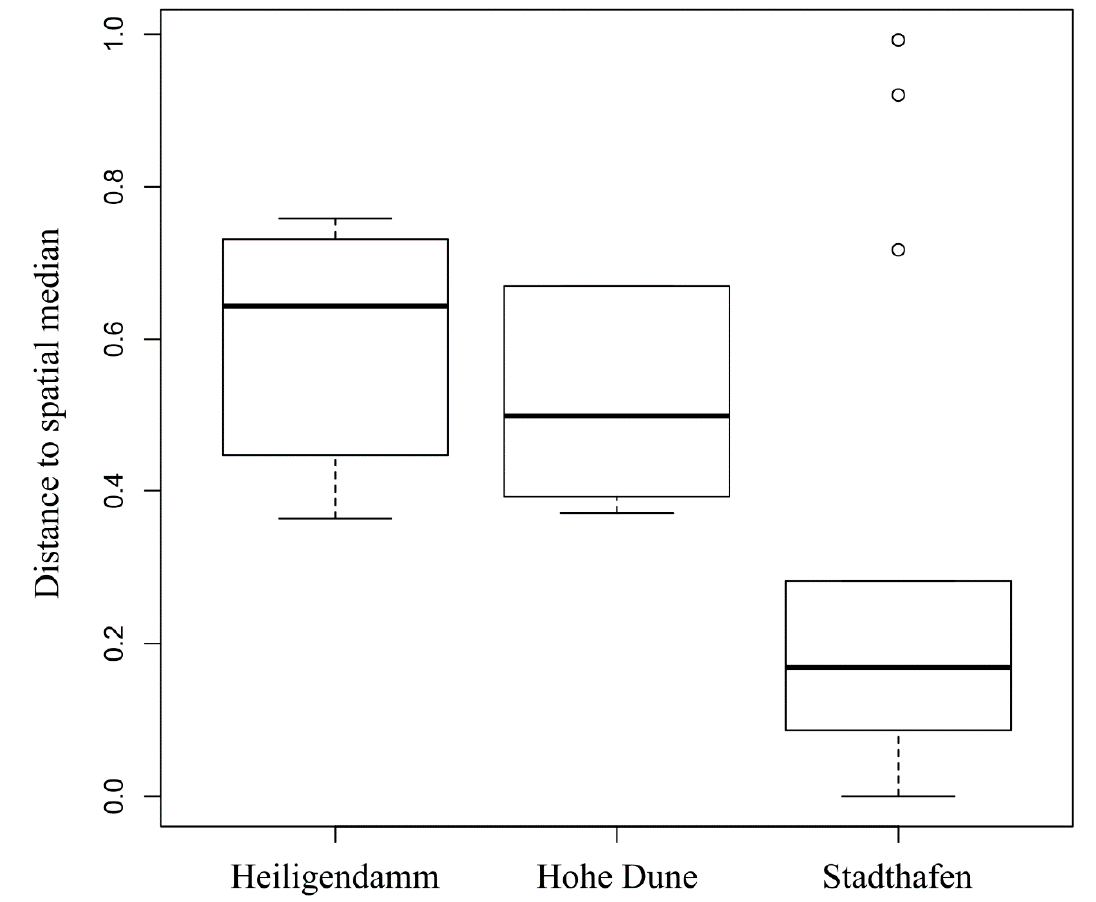
Figure 3. Boxplot depicting the distances to the groups’ spatial medians for the factor “site” of biofilms on PE and PS during the in situ incubation experiment, covering the Warnow river (Stadthafen) and two Baltic Sea coastal stations (Heiligendamm and Hohe Dune), after 1, 5, and 10 h. Groups’ spatial medians were derived from a PCoA-ordination based on Bray–Curtis dissimilarities between Vibrio communities as a measure for community variability.